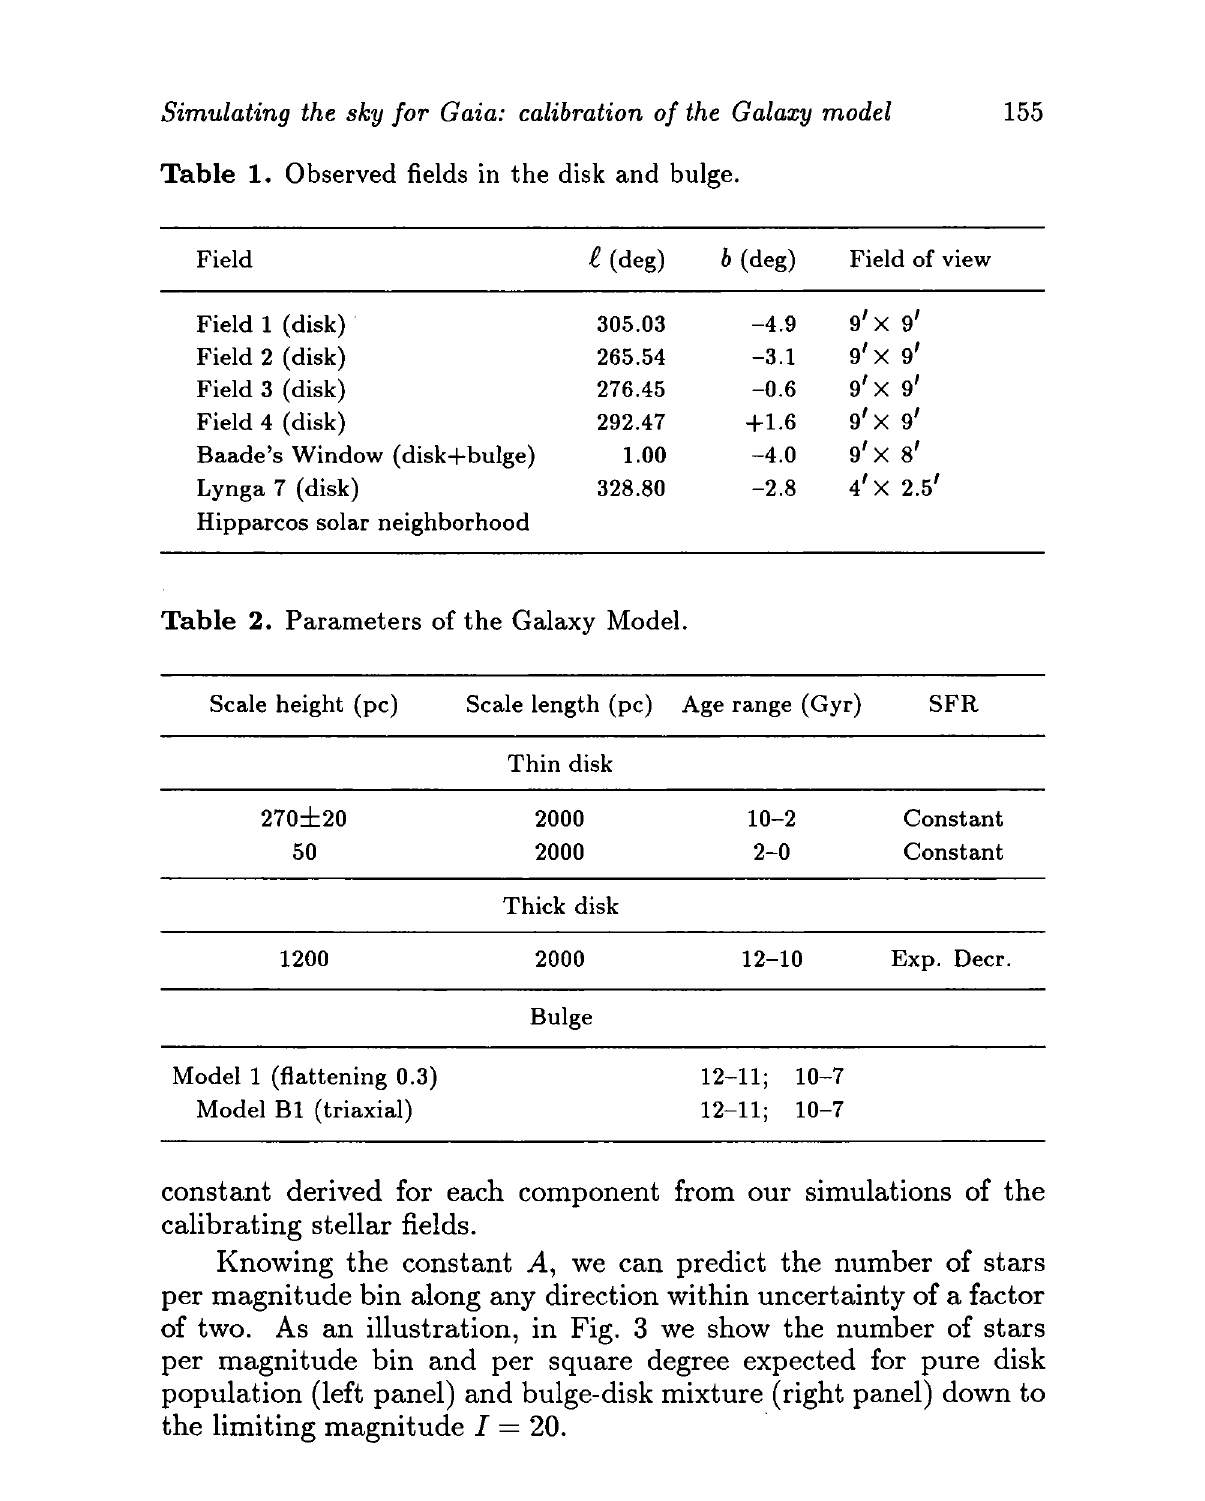
Table 1. Observed fields in the disk and bulge.